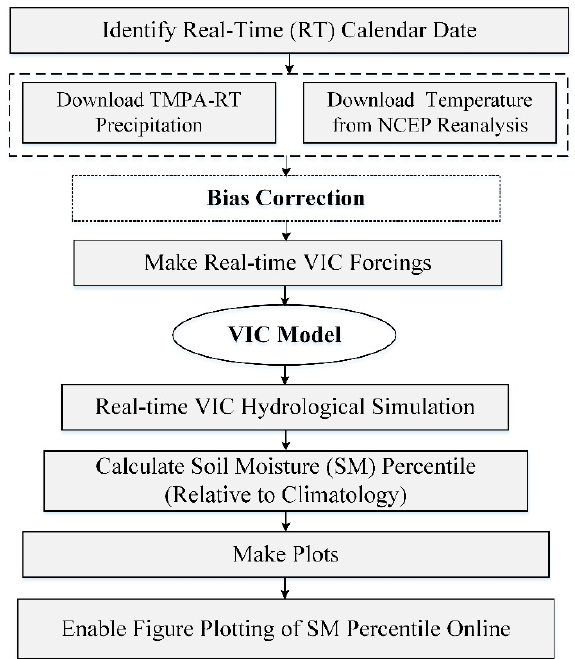
Figure 12. Flowchart of the LMDM operational real-time mode.